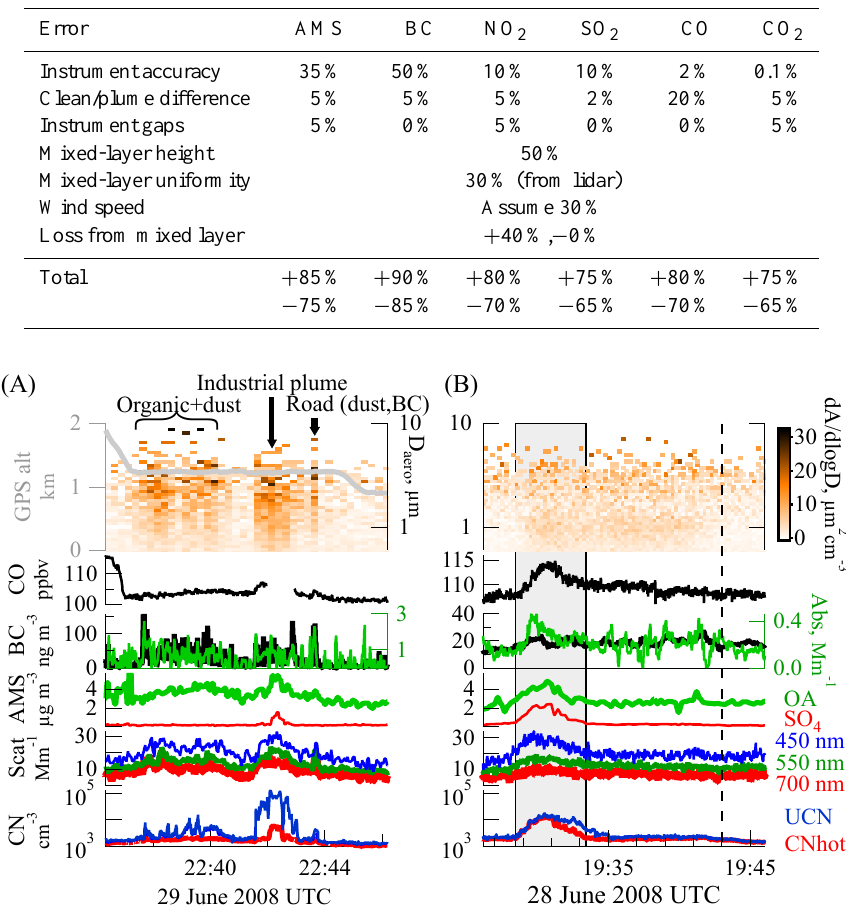
Table 2. Flux error estimates. Total errors are calculated by taking the square root of the sum of the squares of the individual errors. Totals are asymmetrical because losses from the mixed layer are not included in the flux calculation but could have had an effect.